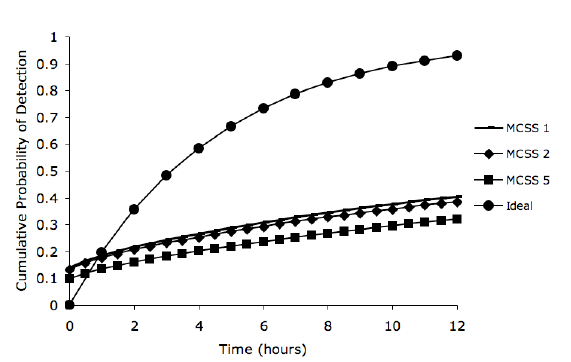
Fig.9. Average CPD of Initial USDEA Mesh Fields Communications Range = 11 kyd